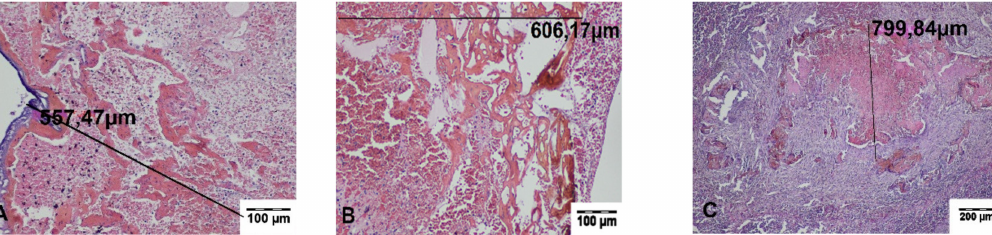
Figure 5. Histopathological sections of the spleen on day 7 following cutting with the thulium-doped fiber laser (TDFL). Black lines indicate the width of the entire zone of thermal damage (HE staining). ( A , B ) The superficial zone of the thermal damage (magnification × 100); ( C ) residues of the carbonized tissue surrounded by the parenchyma with visible processes of repair and regeneration (magnification × 40).